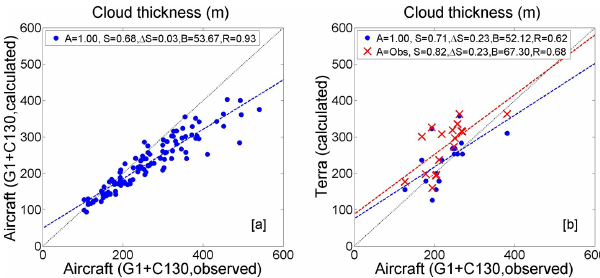
Fig. 10. Comparison of retrieved cloud geometrical thickness with the in-situ